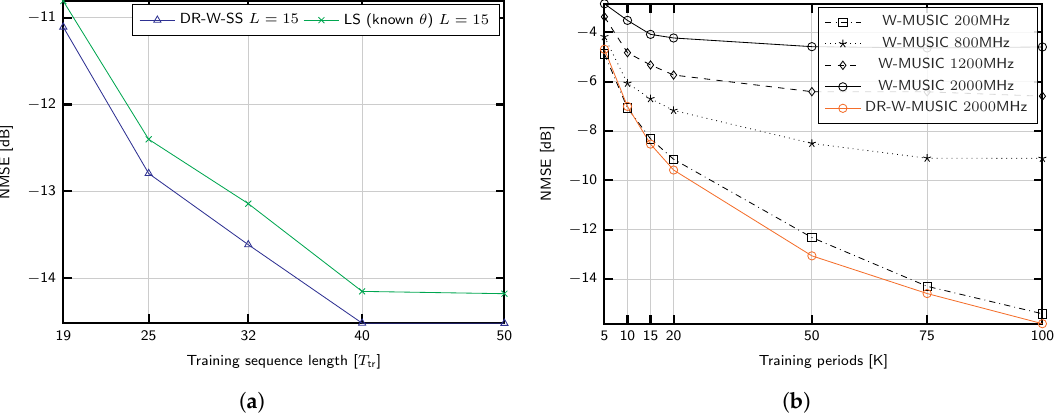
Figure 4. NMSE of covariance estimation for ( a ) M = 100 antennas, L = 50 propagation paths, K = 50, SNR = 15 dB, and different training sequence lengths; ( b ) M = 200 antennas, L = 5 propagation paths, and different signal bandwidths B for f c = 28